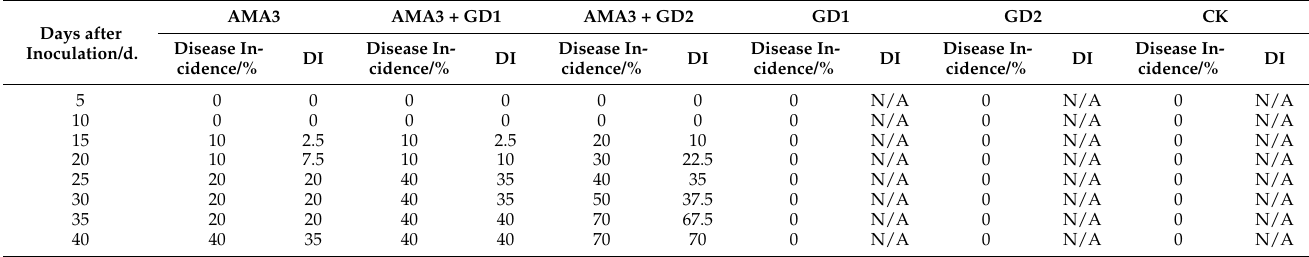
Table 3. Disease incidence and disease index (DI) of Pinus massoniana inoculated with different treatments of pine wood nematodes. CK—control